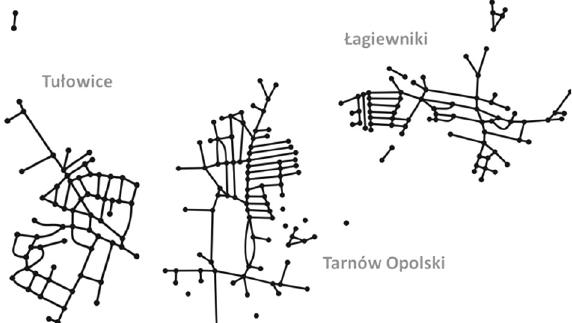
Fig. 13. Graphs depicting the morphology of lowland villages with the population below 2,500 inhabitants (LV7-LV8). Source: own work.